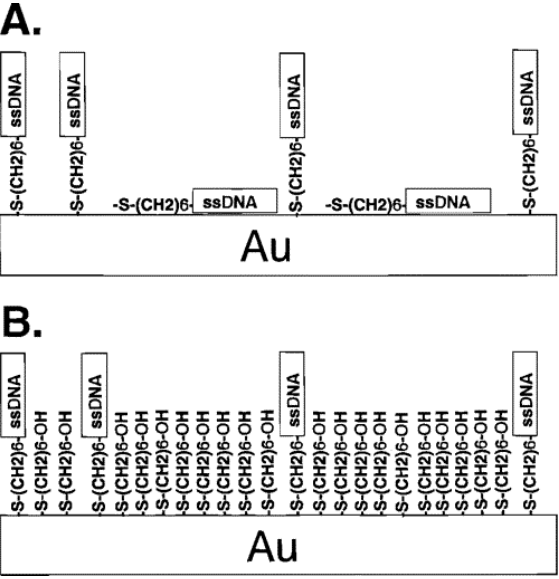
Figure 11. Schematic of ( A ) HS-ssDNA on Au and ( B ) both HS-ssDNA and MCH adsorbed on gold. Reprinted with permission from Ref. [61]. copyright © 2022, American Chemical Society.